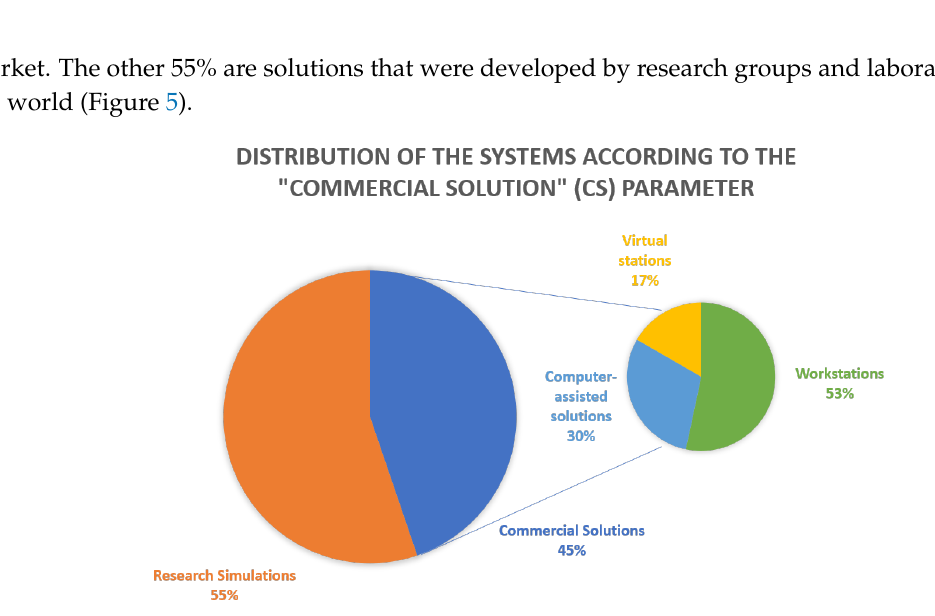
Figure 5. Distribution of the analyzed papers in terms of the “commercial solution” (CS)